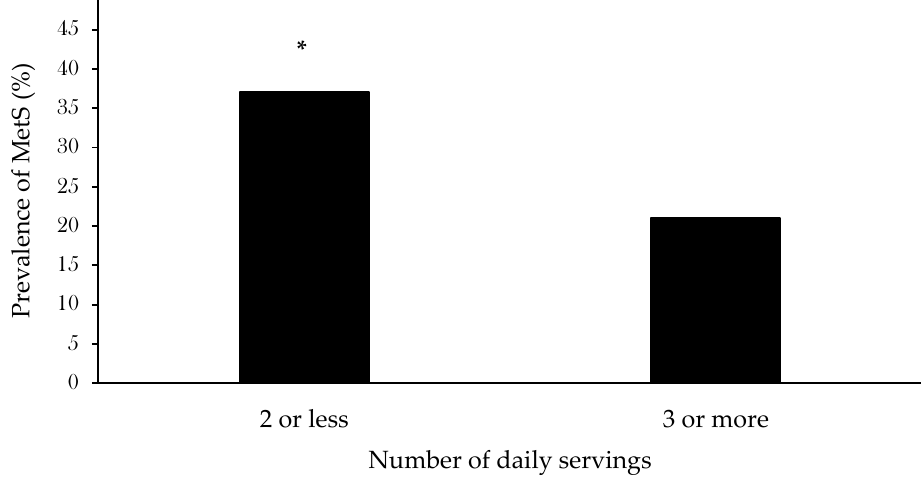
Figure 1. Prevalence of MetS in participants with lower ( ≤ 2) and higher ( ≥ 3) number of daily FV servings. * p < 0.05.